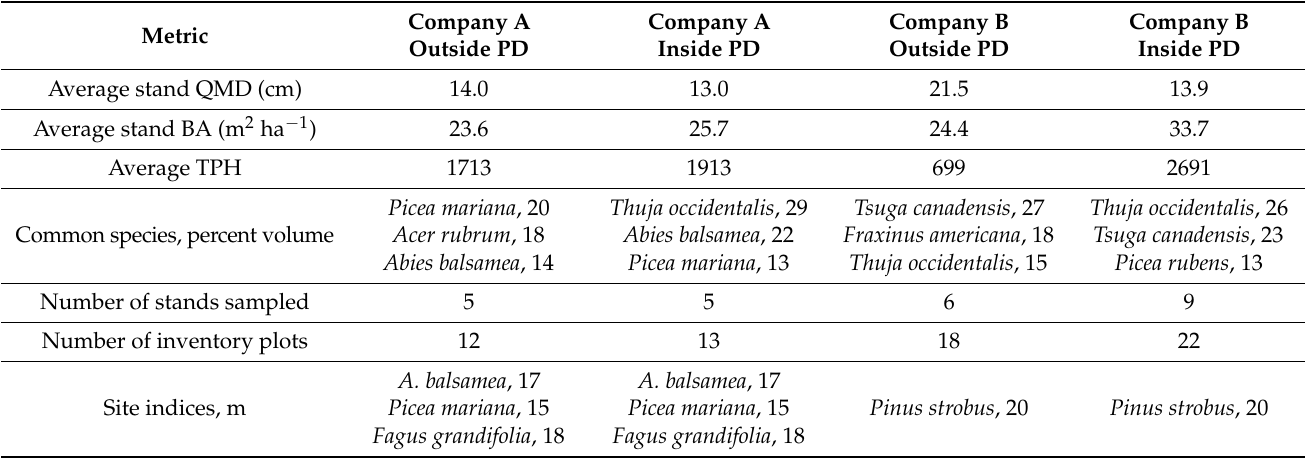
Table 2. Summary of the stand metrics of the inventory tree lists used in modeling forest management scenarios inside and outside of protected deeryards (PDs) in Maine. Quadratic mean diameter (QMD), basal area (BA), and trees per hectare (TPH) were exported from internally calculated FVS stand summaries. The site index was from USDA Natural Resources Conservation Service Web Soil